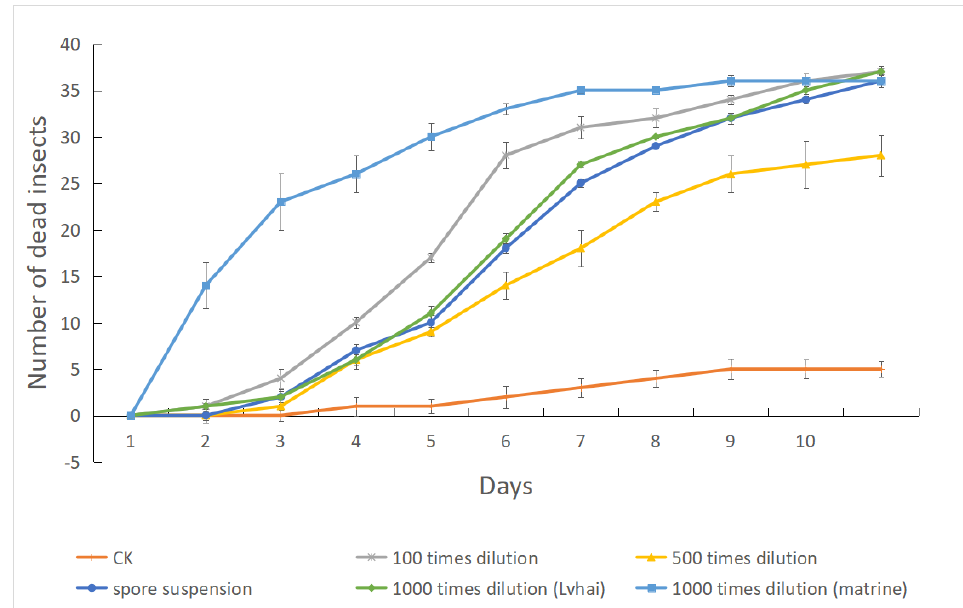
Figure 3 . Mortality trend of P. bilinealis larvae with different treatment solutions. Bars represent standard errors of three replicates. standard errors of three